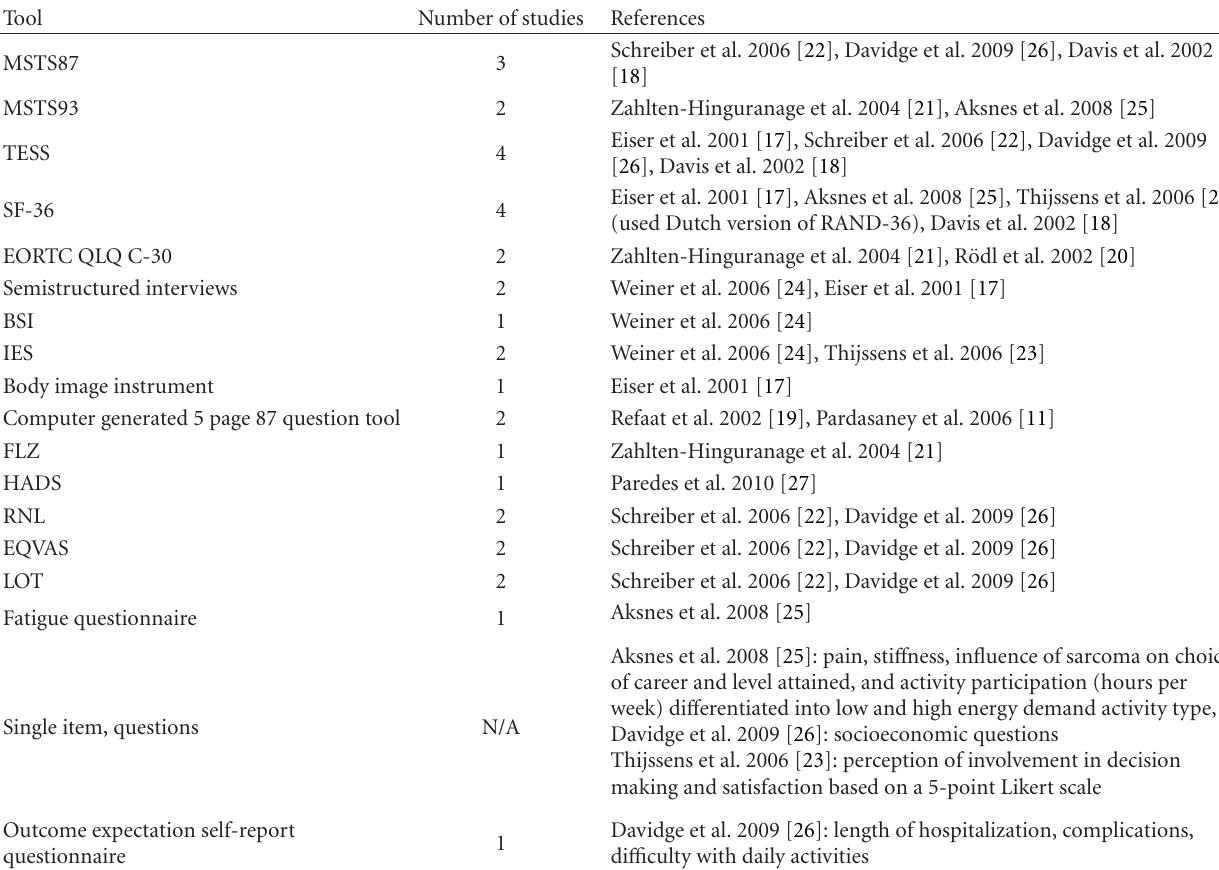
Table 2: Tools used in the assessment of QoL in sarcoma